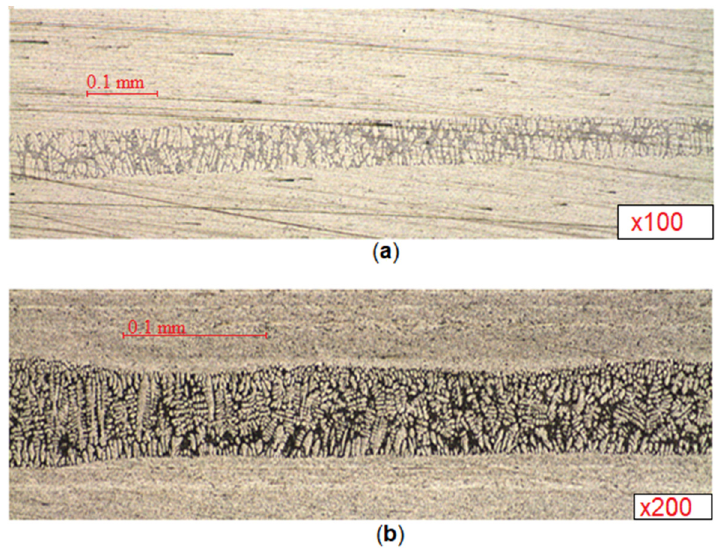
Figure 23. Microsections of the brazed waveguides: ( a ) microsection of a pipe-flange waveguide assembly; ( b ) microsection of a pipe-coupling waveguide assembly.